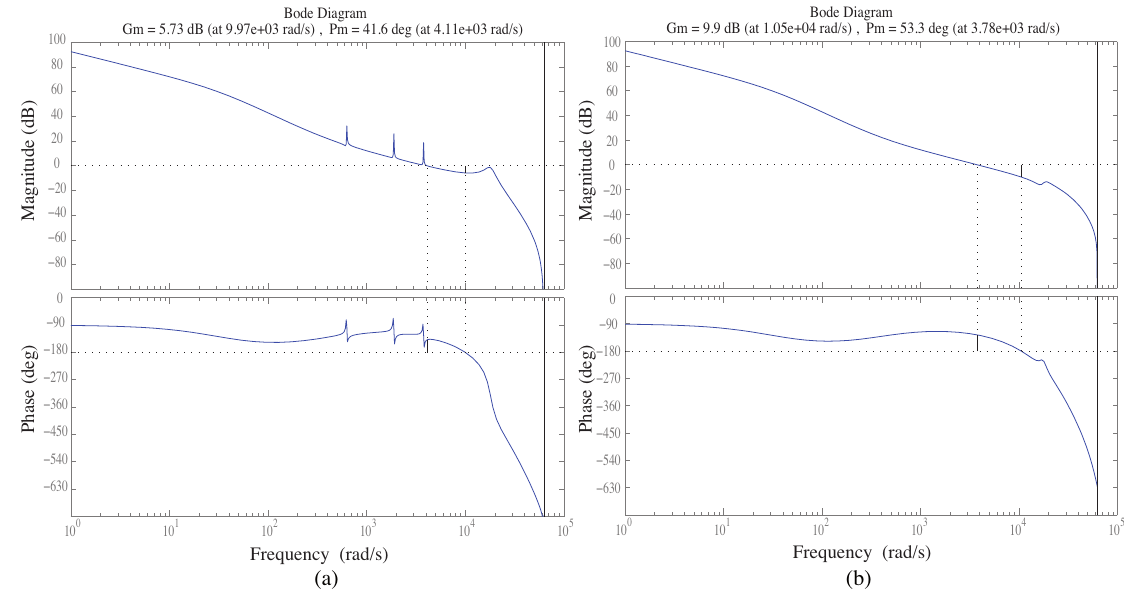
Figure 5. Open-loop bode diagram for Grid Current Feedback (GCF) ( a ) and CCF ( b ) strategy.